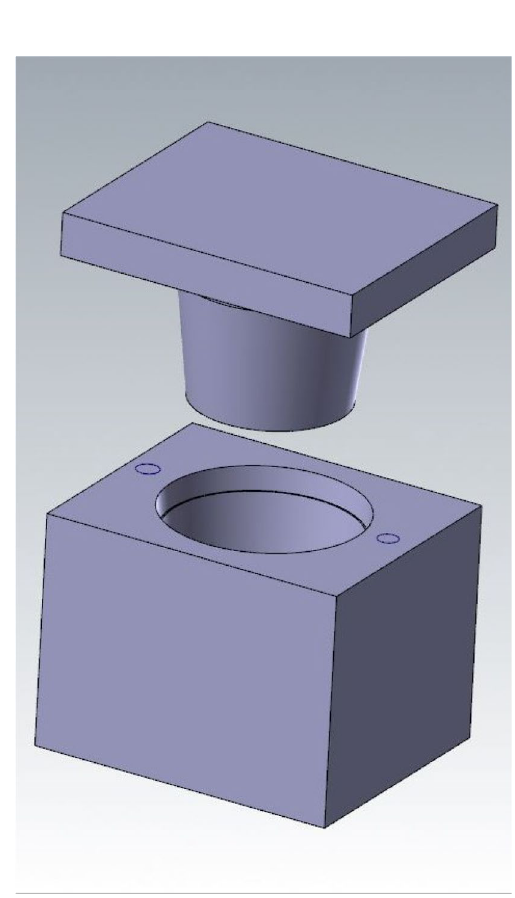
Fig. 18 Core and cavity of the pot mold